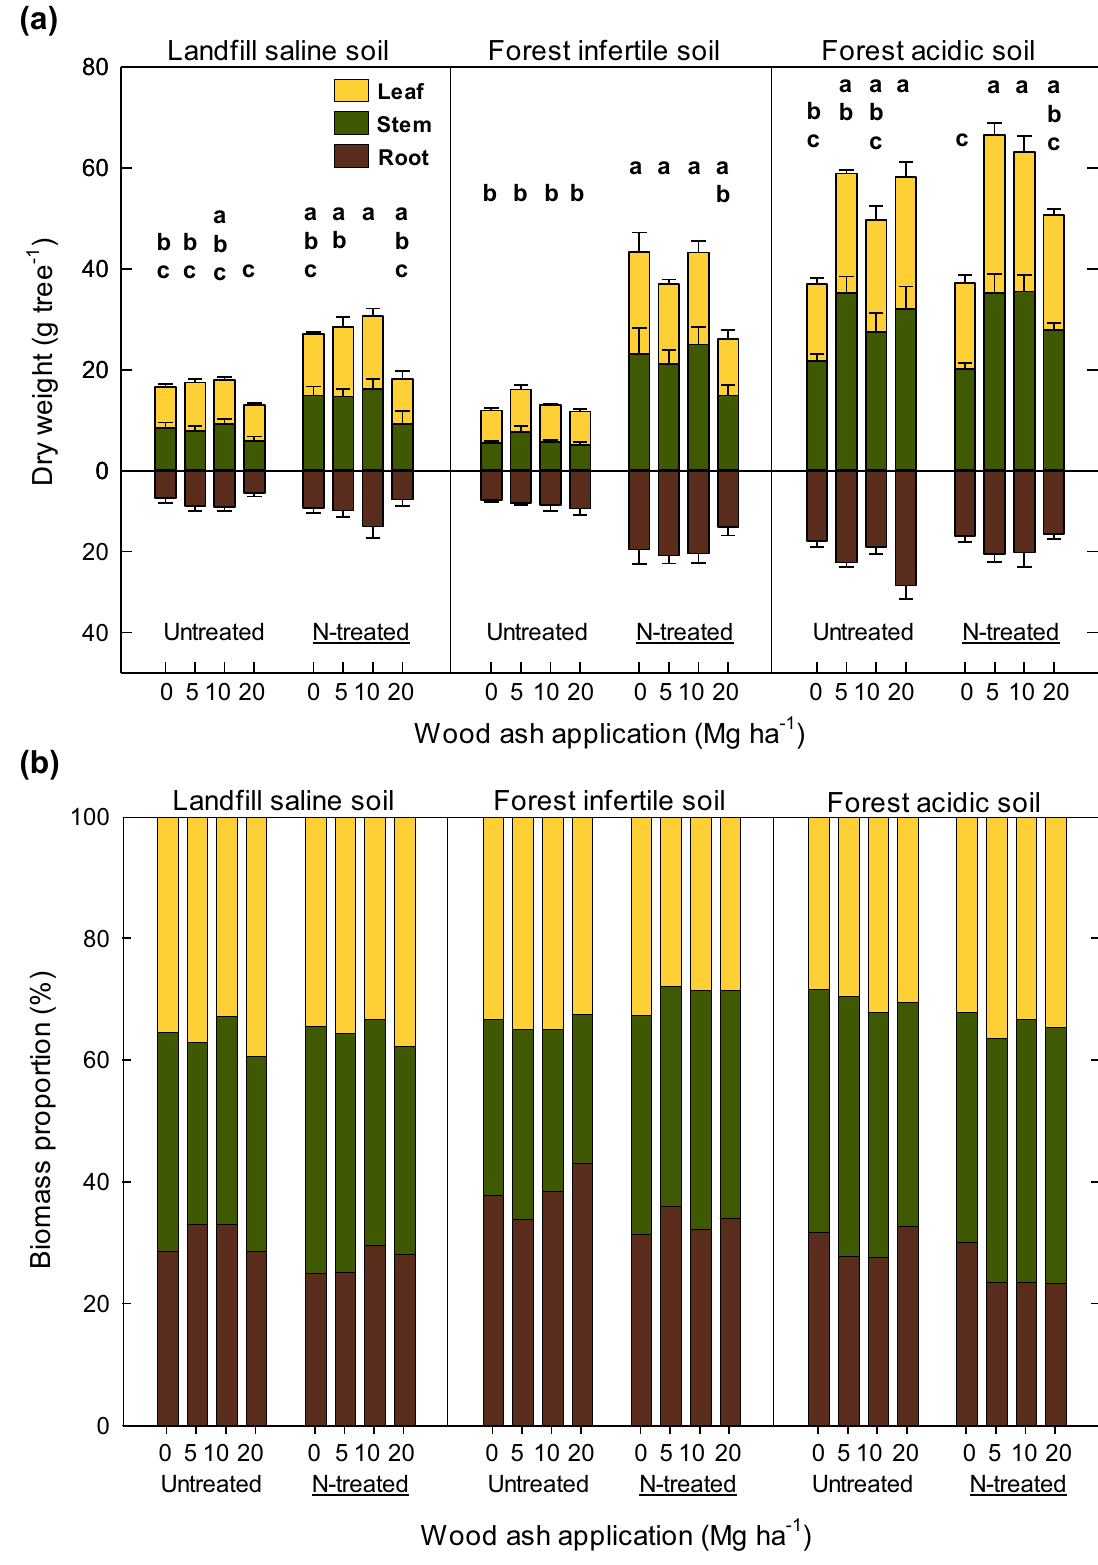
Figure 1. ( a ) Dry weight and ( b ) biomass proportion of aboveground (leaf and stem) and belowground (root) of Zelkova serrata seedling grown across three soil types (landfill saline soil, forest infertile soil, and forest acidic soil) applied with four levels of wood ash (0, 5, 10, and 20 Mg ha −1 ) and two levels of N fertilizer (0 and 150 kg ha −1 ). Vertical bars represent standard errors (n = 5). Different lower case letters within each soil indicate significant differences (p < 0.05, Tukey–Kramer comparison lines for least squares means) in each tissue across four wood ash levels and N fertilizer